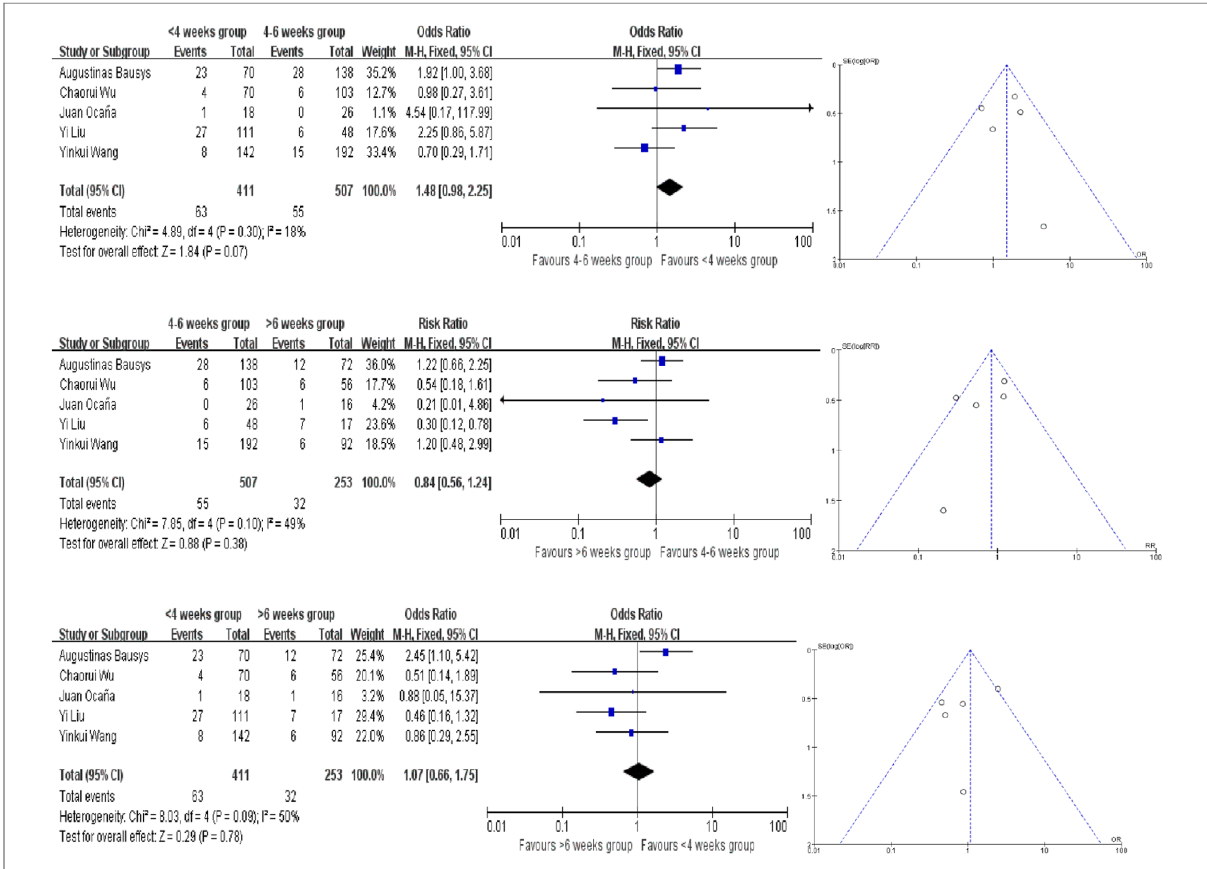
FIGURE 2 Forest plot and funnel plot for pathologic complete response (pCR) rates meta